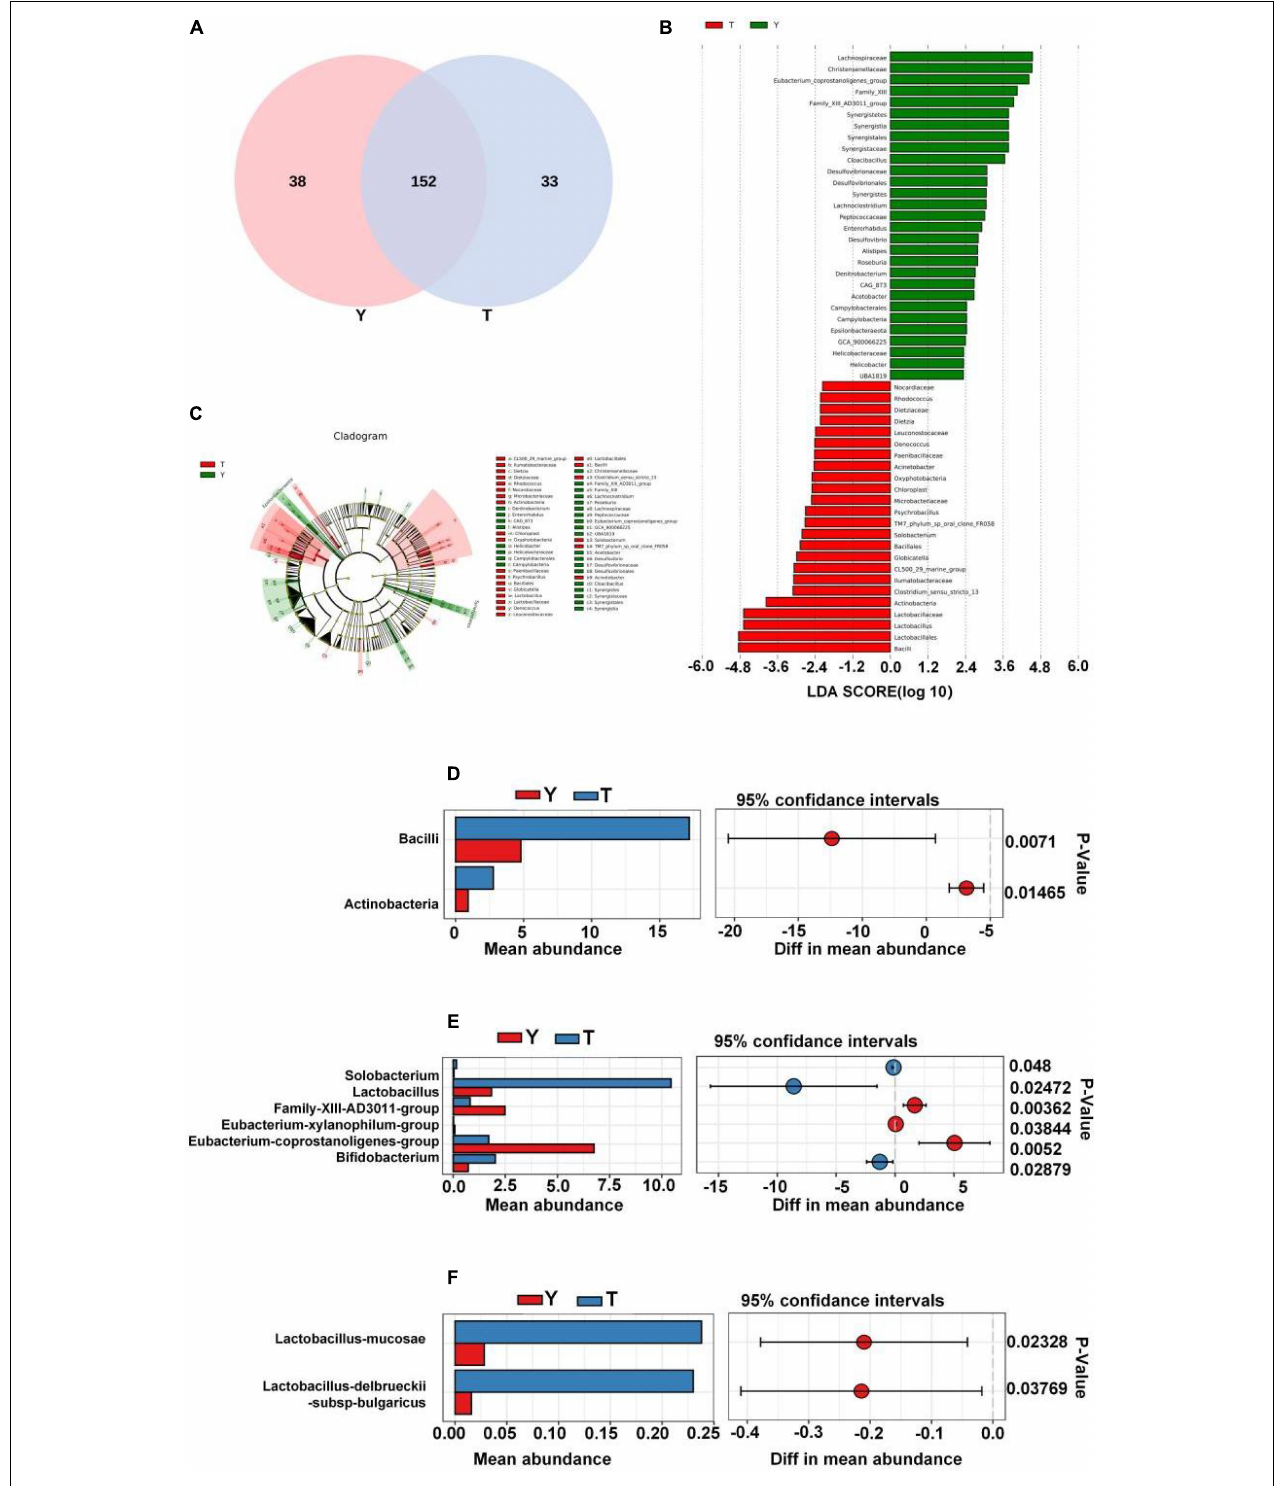
FIGURE 6 | Differences in intestinal microbial composition between Tibetan (T) and Yorkshire (Y) pigs. (A) Venn diagram analysis of colonic intestinal microflora in T and Y groups at genus level. (B) Variation in abundances of different species between T and Y groups (Linear Discriminant Analysis, LDA > 2). (C) Phylogenetic distribution map of microbial communities related to T and Y groups. In the evolutionary tree, the circles from inside to outside represent different levels, and the yellow circles represent taxa with obvious differences. There were significant differences in the class (D) , genus (E) , and species (F) levels of colonic microflora between groups T and